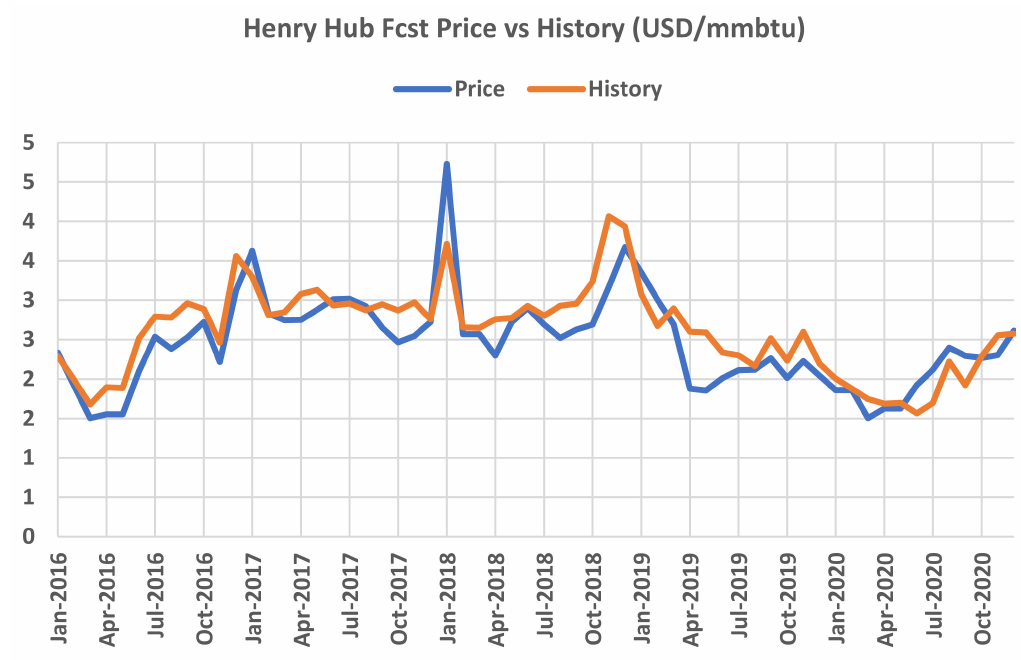
Figure 14. Calibrated gas price versus historical value for Henry